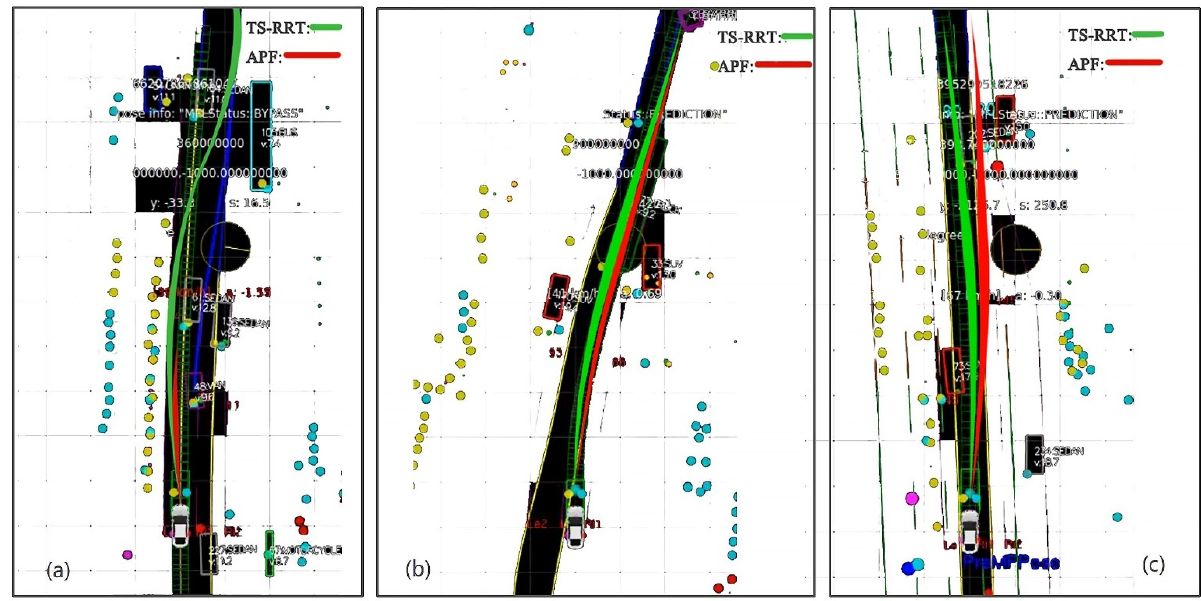
Figure 5. Comparison of algorithm effectiveness under motorway running: ( a ) bypassing in jam- packed case, ( b ) bypassing in normal case, ( c ) overtaking case.